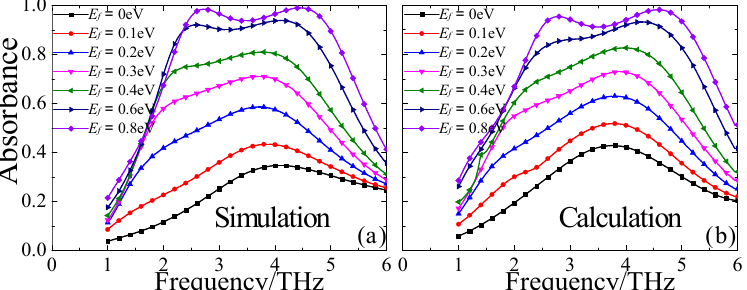
Figure 6. The ( a ) simulated and ( b ) calculated absorbance spectra under normal incident TE waves with different Fermi energy levels ( E f ).